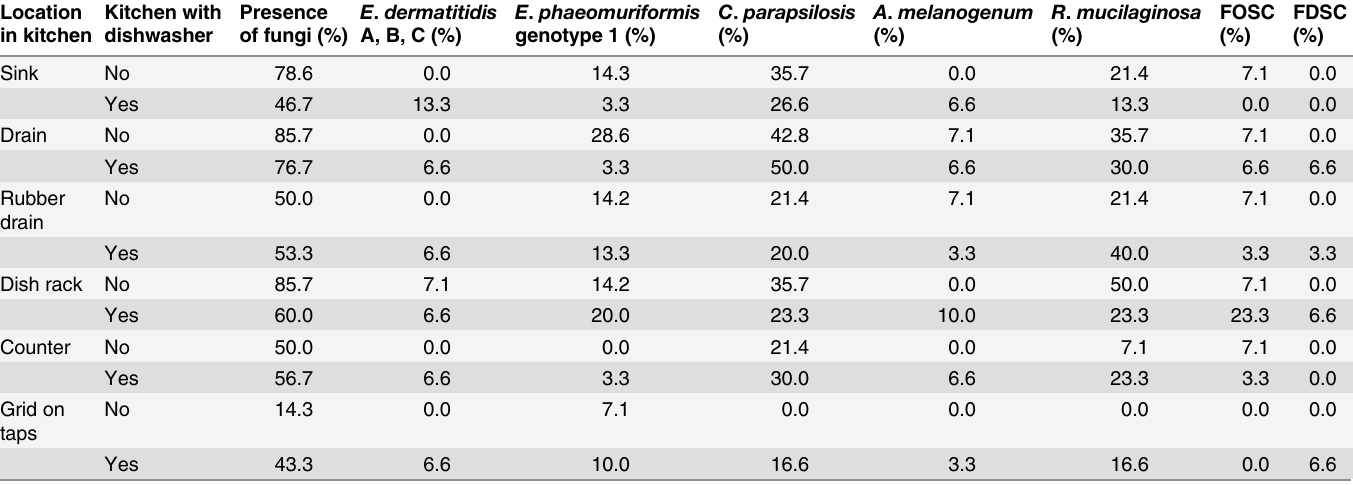
Table 4. Occurrence (%) of selected opportunistic pathogenic fungi in kitchens without and with dishwashers. E . dermatitidis Location Kitchen with Presence in kitchen dishwasher of fungi (%) A, B, C (%)